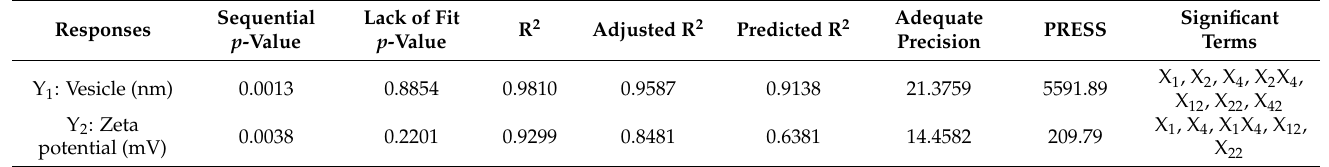
Table 3. Fit statistics of QRT-PHM-SV responses according to quadratic model.